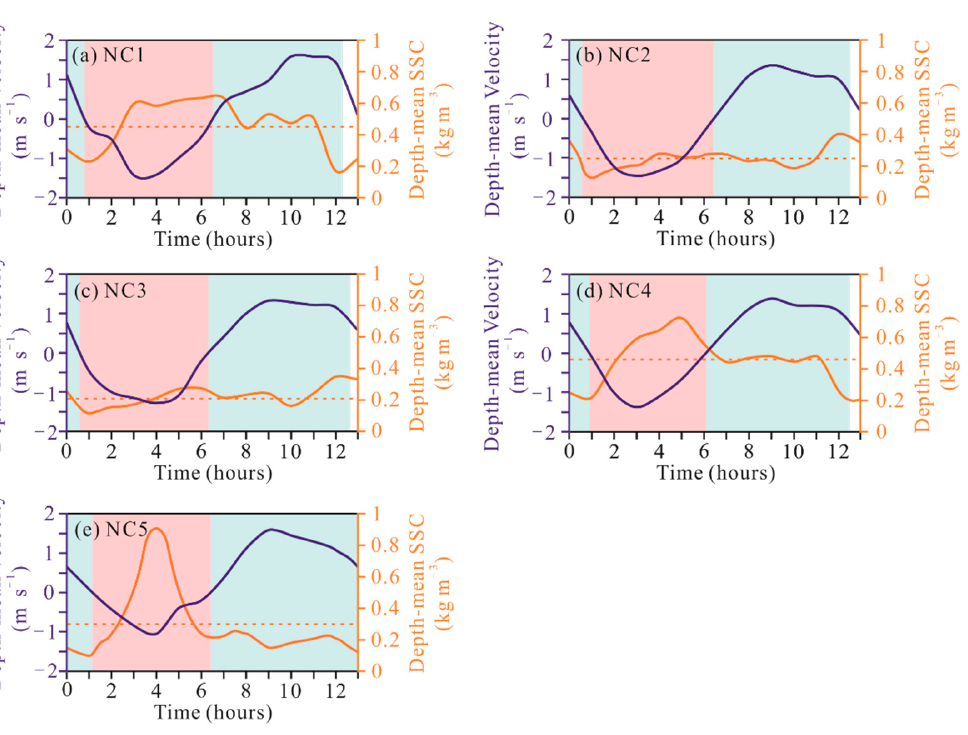
Figure 8. Temporal variations of depth-averaged velocities (m s − 1 ) and depth-averaged SSC (kg m − 3 ) at NC1 to NC5 stations ( a – e ), where dashed lines mean tidally averaged SSC (kg m − 3 ). Therefore, at the NC1, NC4 and NC5 stations in channel, flood tidally averaged SSC were larger than ebb tidally averaged. At the NC1 station, the tidally averaged SSC were 0.48 kg m − 3 over flood tide and 0.42 kg m − 3 over ebb tide. At the NC4 station, the tidally averaged SSC were 0.50 kg m − 3 over flood tide and 0.43 kg m − 3 over ebb tide. At the NC5 station, the flood tidally averaged SSC was 0.45 kg m − 3 and ebb tidally averaged SSC was 0.20 kg m − 3 . At the NC1 and NC4 stations, the flood tidally averaged SSC above 0.8 h were